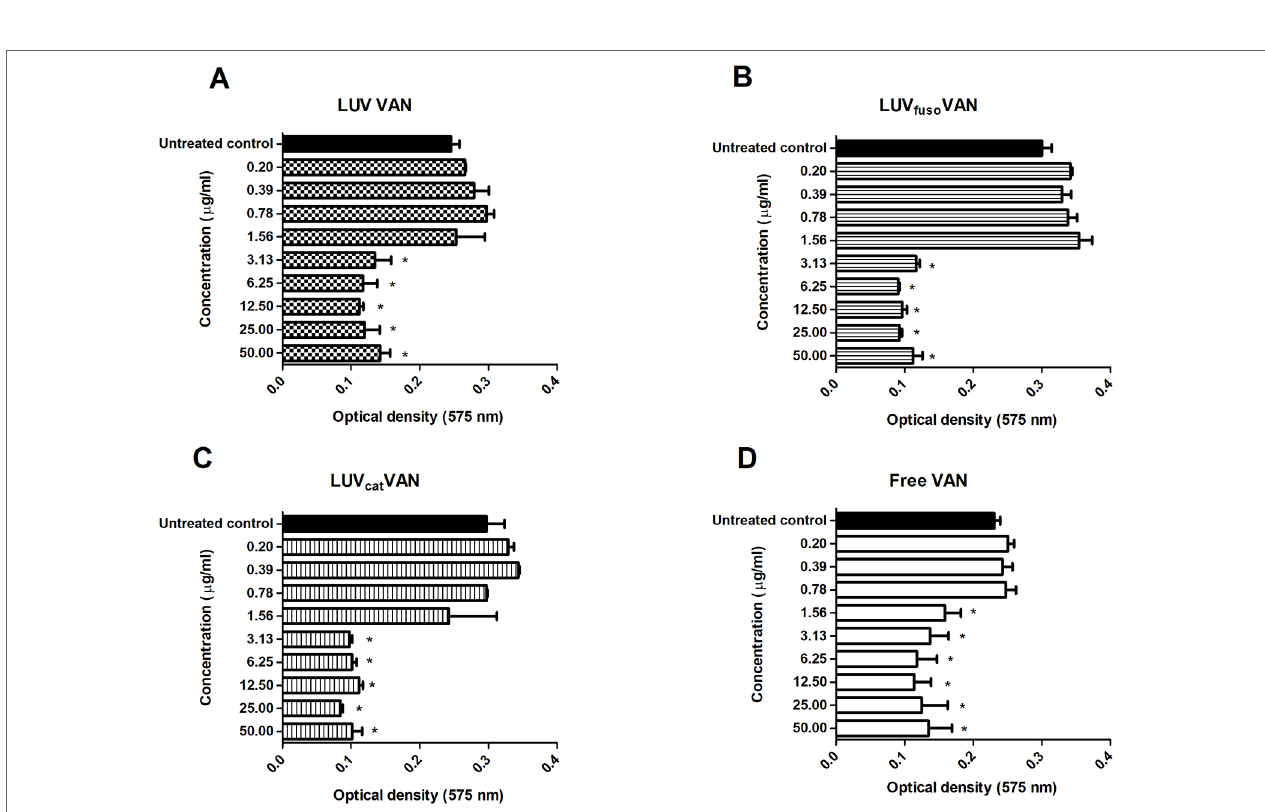
FIgUre 4 | Free and liposome-encapsulated VAN formulations for their inhibitory effects on S . aureus ATCC 29213 biofilm adherence. Mean ( ± SD) optical density values of S. aureus biofilms treated with different concentrations of VAN encapsulated into LUV VAN (A) , LUV fuso VAN (B) , LUV cat VAN (C) , or free VAN solution (D) . The asterisk “*” indicates statistically significant difference between the drug treatment and its respective untreated control at p < 0.05 (One-way ANOVA, followed by Tukey’s post-hoc test).